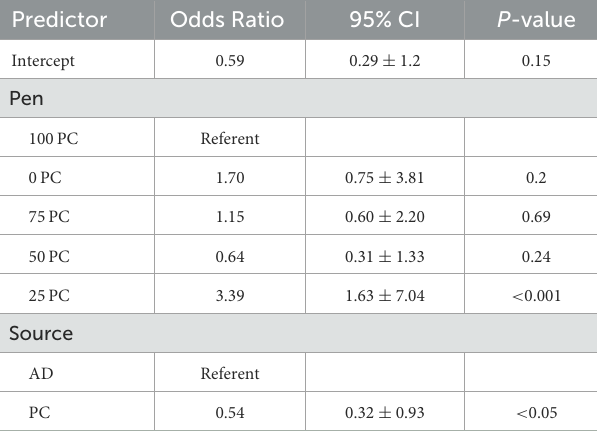
TABLE 2 Final multivariate logistic regression model for morbidity related to BRD at pen level by source.